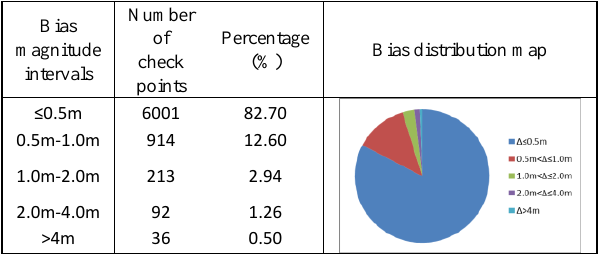
Table 3. Statistics of elevation biases between the extracted DEM and airborne LiDAR point cloud